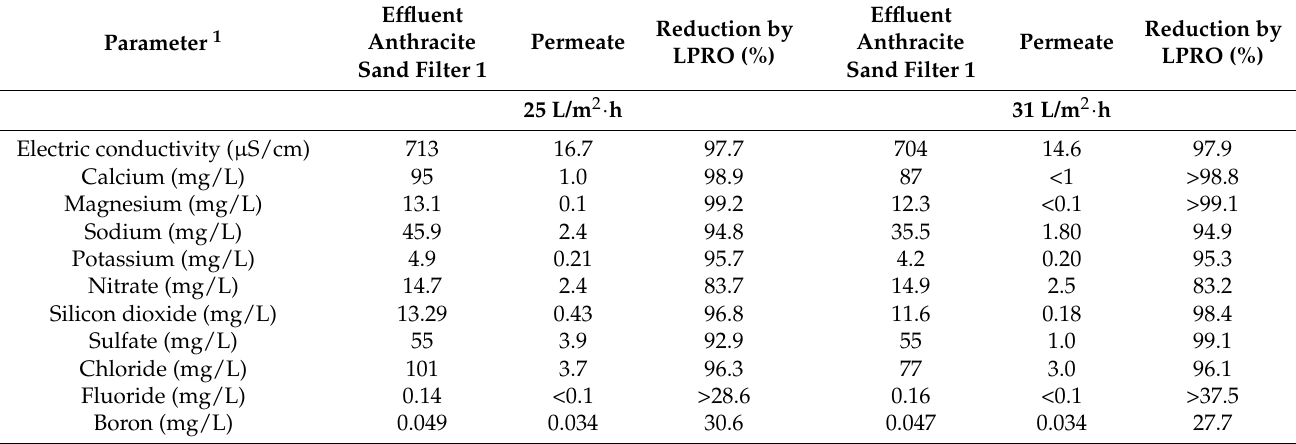
Table 5. Inorganic parameter of filter drains, ACF drain and LPRO permeates at two fluxes of 25 and 31 L/m 2 · h